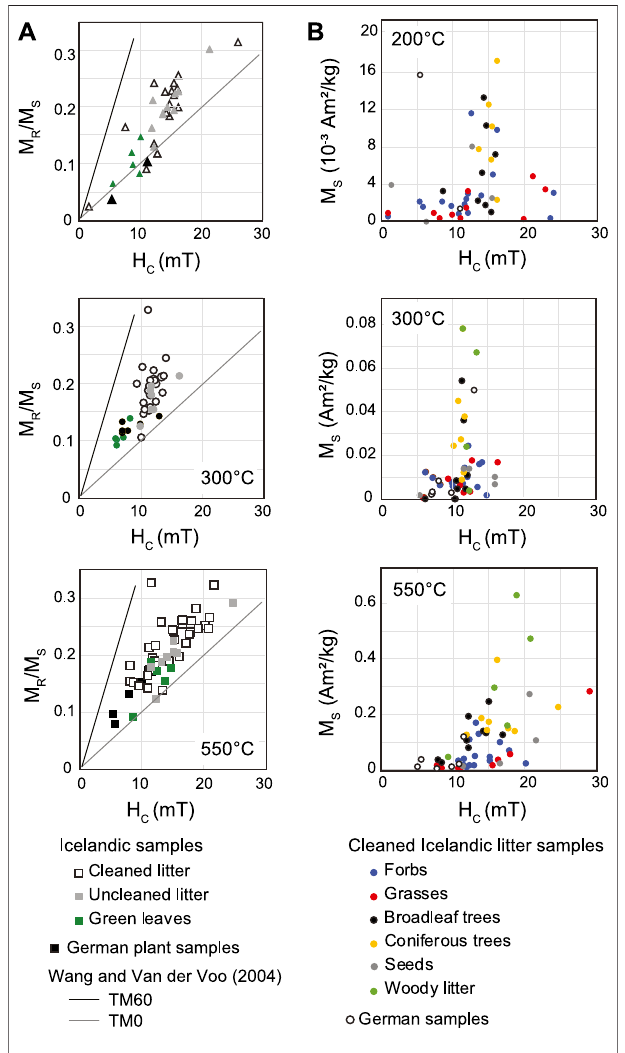
FIGURE 6 | (A) Hysteresis squareness ( M R / M s vs. H c plots for ash and char from different subsets of plant samples along with compositional trends proposed by Wang and Van der Voo (2004). (B) Variations in saturation magnetization vs. coercivity by plant type for ash and char from cleaned Icelandic litter